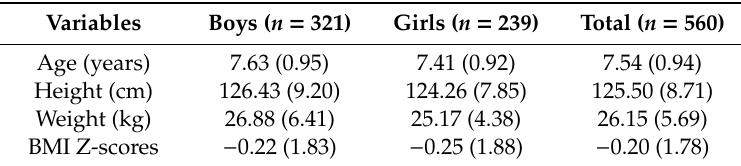
Table 1. Descriptive data of the participants by gender ( n =